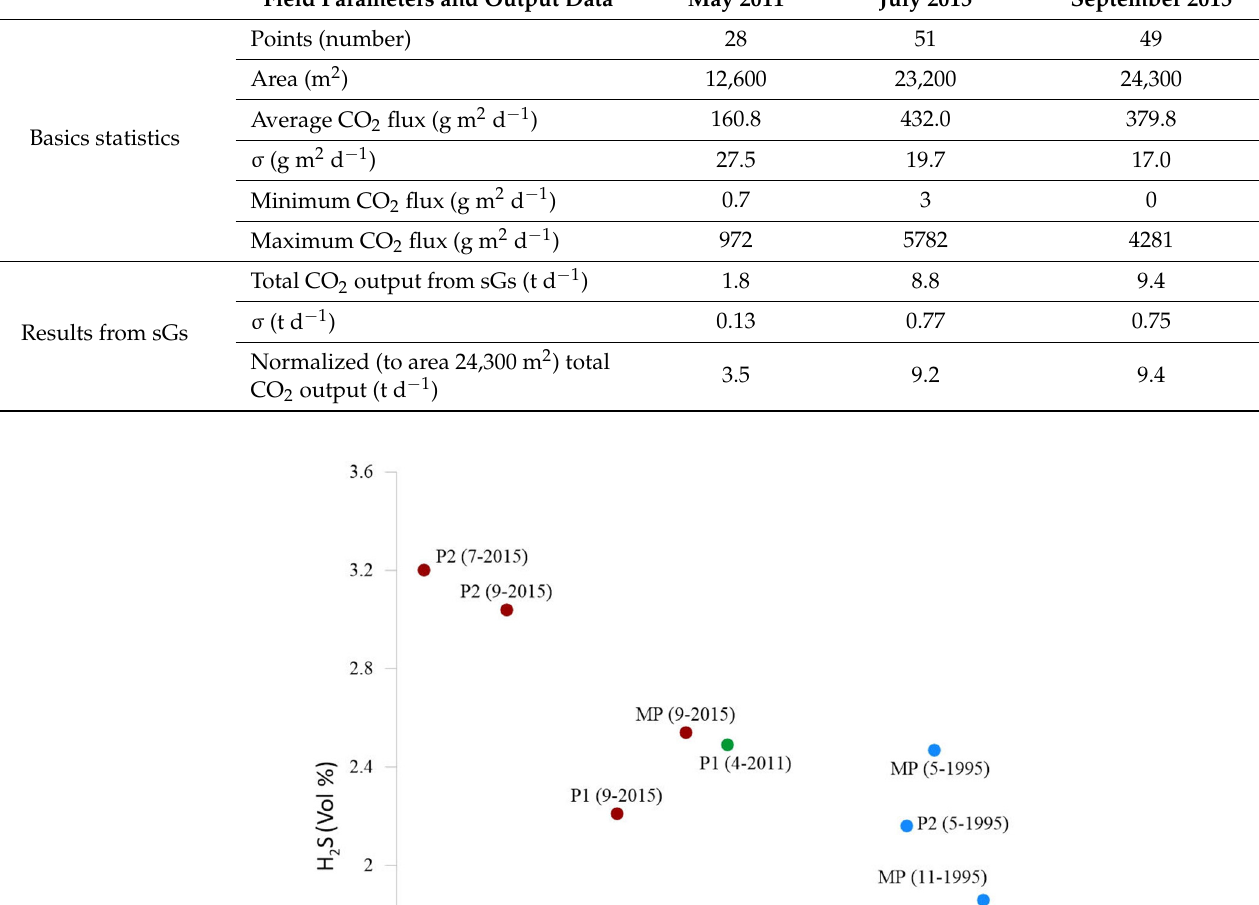
Table 2. Soil CO 2 output in the Baia di Levante Area from field measurements in May 2011, and July and September 2015. Field Parameters and Output Data